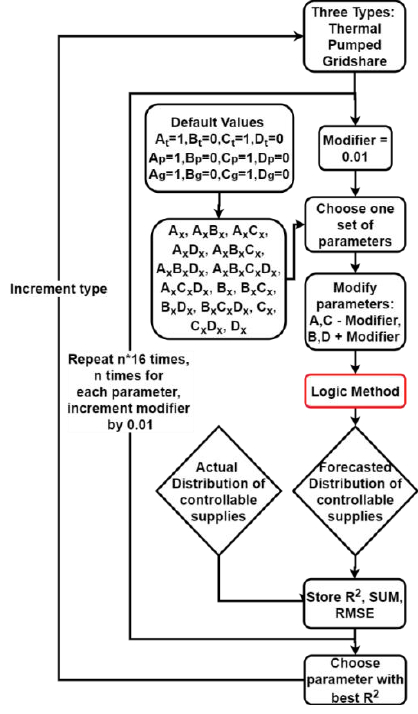
Figure 9. Calibration method flowchart. A, B, C, and D indicate the calibration parameters with subscript t representing thermal, p for pumped storage, and g for grid interconnection. The default values for four parameters are 1, 0, 1, and 0. Then, they are being adjusted by the modifier with 0.01 value during calibration.